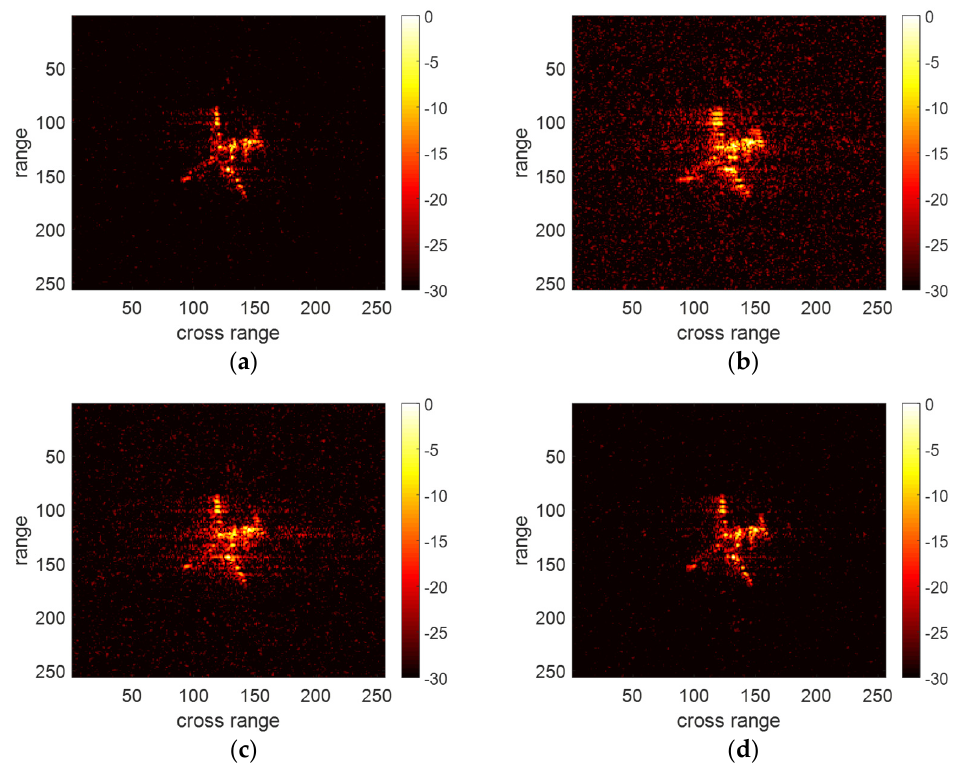
Figure 6. Translational motion compensation result of different methods under SNR = 0 dB. ( a ) Ideal result. ( b ) Result of PSO. ( c ) Result of PD ‐ KT ‐ FrFT. ( d ) Result of the proposed method.